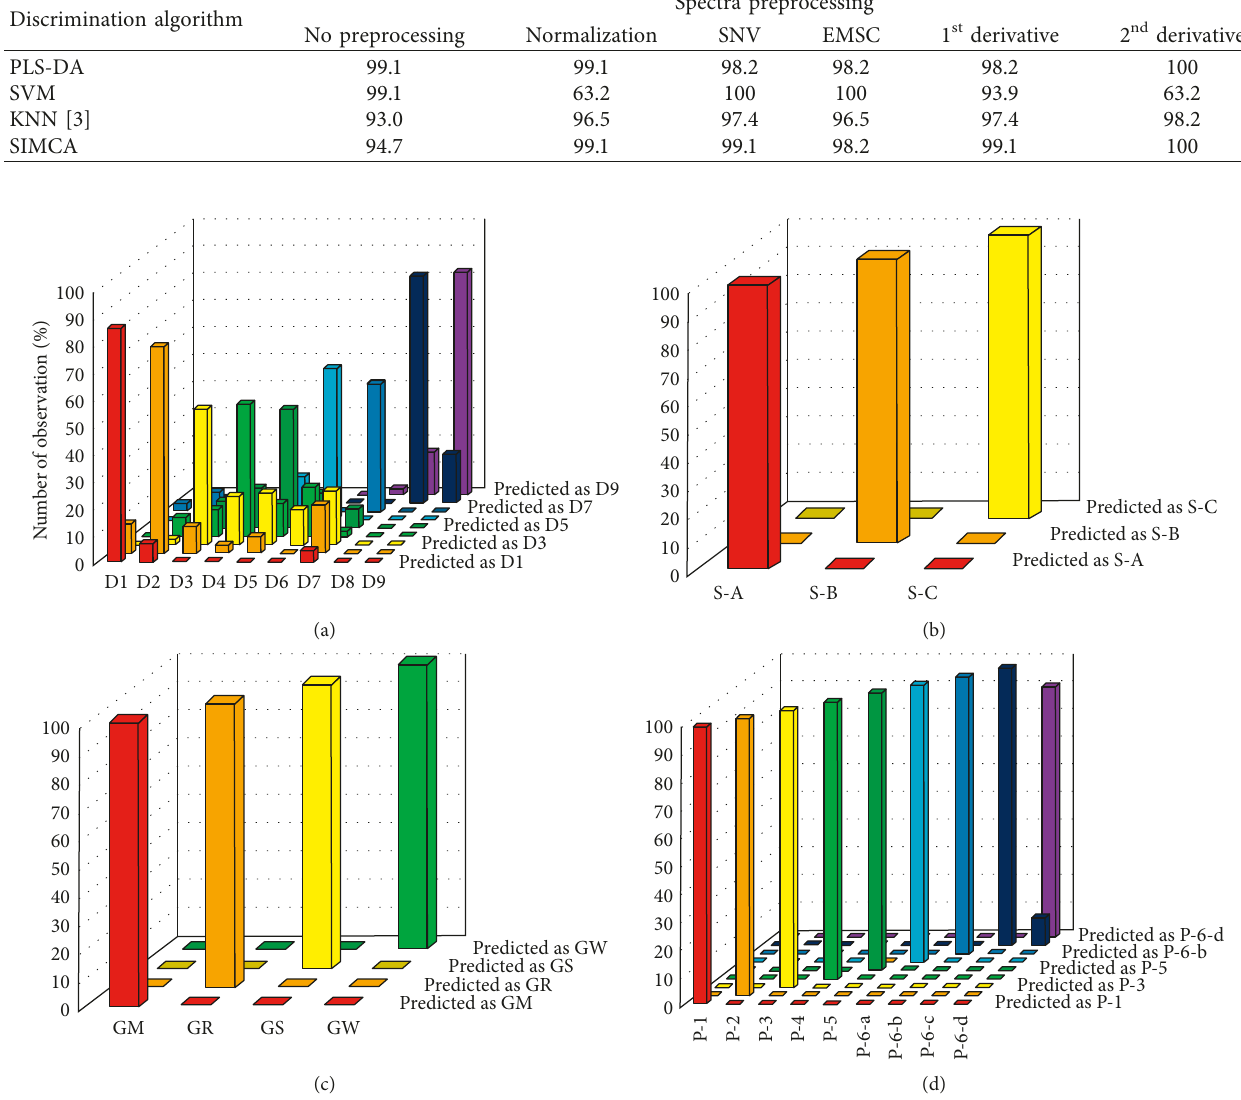
Figure 4: Confusion table of the particleboard batch prediction with the prototype NIR expert system: project LIDER-D (a), OSU-S (b), ITD-G (c), and industry-P (d).